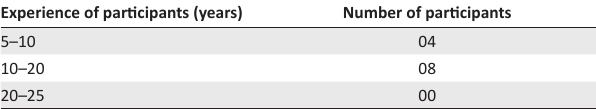
TABLE 2: Summary of population, sample size and data collection methods. Population Sample size Data collection method TABLE 4: Work experience of study participants in years.